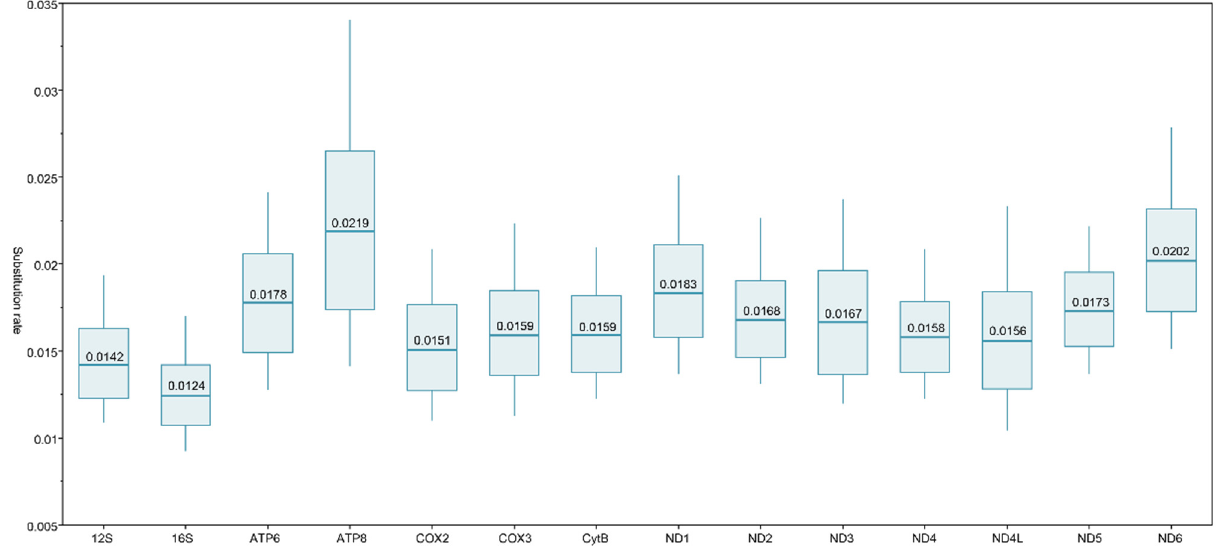
Figure 4. Substitution rates for 12 protein-coding and 2 rRNA mitochondrial genes. The mean value is provided within the boxplot (substitution per site × My − 1 ), whiskers stand for value range, box stand for SD.